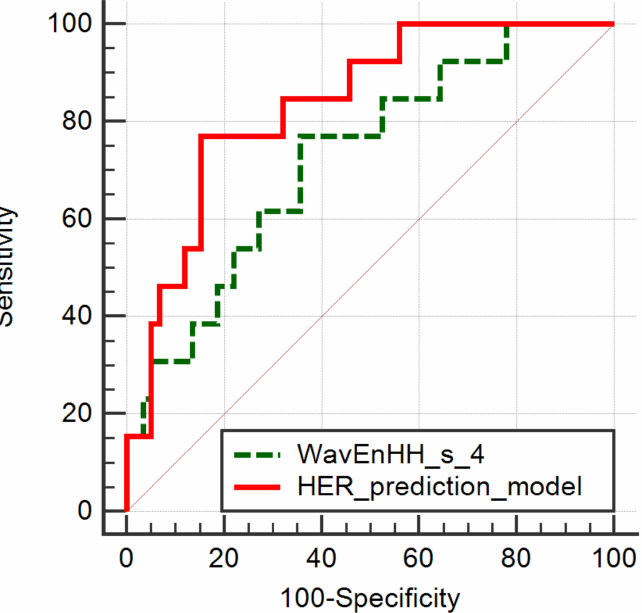
Figure 3. ROC curves of the WavEnHH_s_4 parameter that was independently associated with the HER+ status and the HER prediction